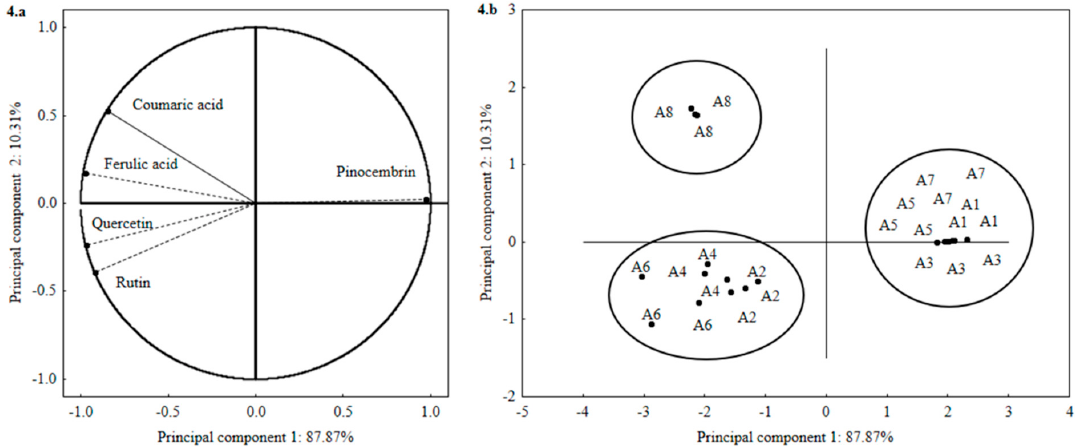
Figure 4. Perceptual map of principal component analysis. Results obtained from distribution of five phenolic compounds in the leaves of Tabernaemontana catharinensis . ( a ) Loading plot for the phenolic compounds on principal components 1 and 2; ( b ) scores plot.